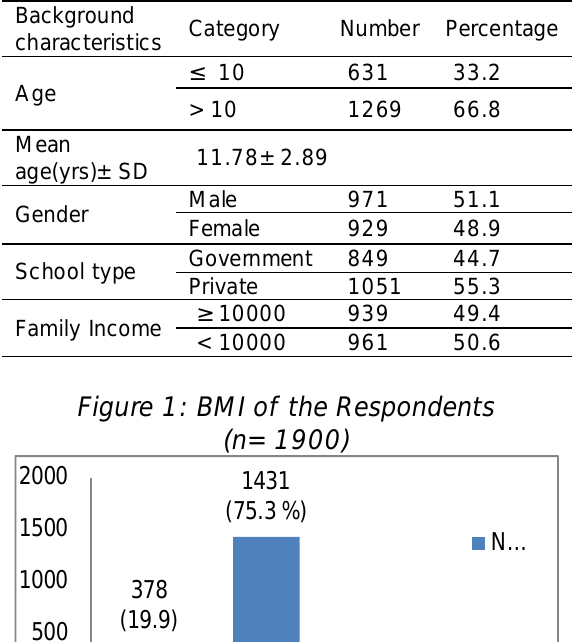
Table 1: Socio-demographic characteristics of the participants (n=1900)